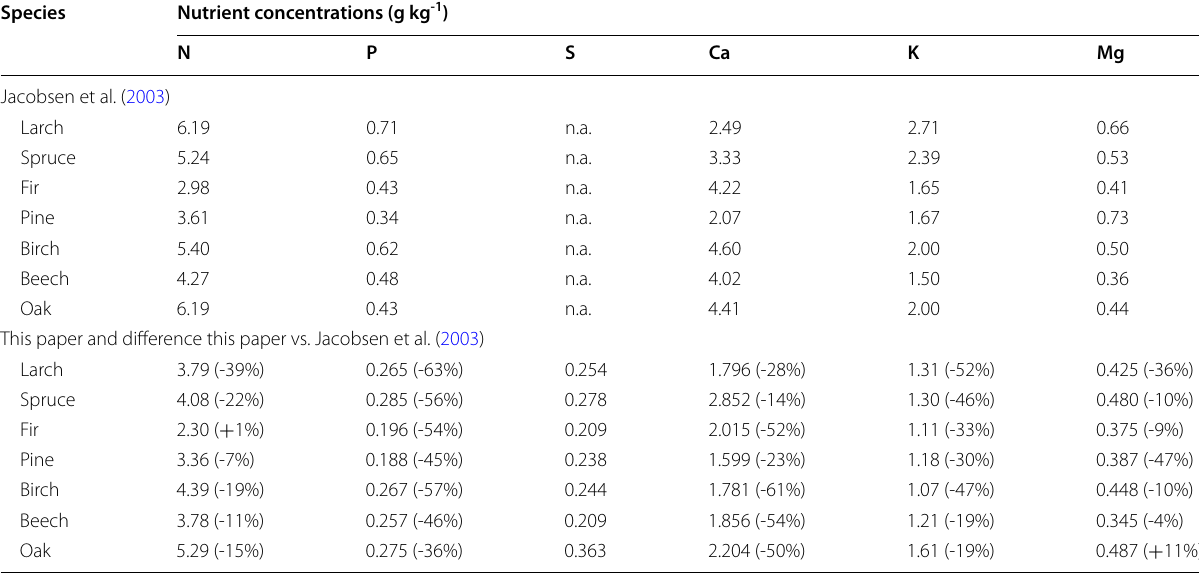
Table 3 Average concentrations (g kg -1 ) of major nutrients in branches, both including bark, according to Jacobsen et al. (2003) and this paper and the relative difference (%) between both datasets (% difference